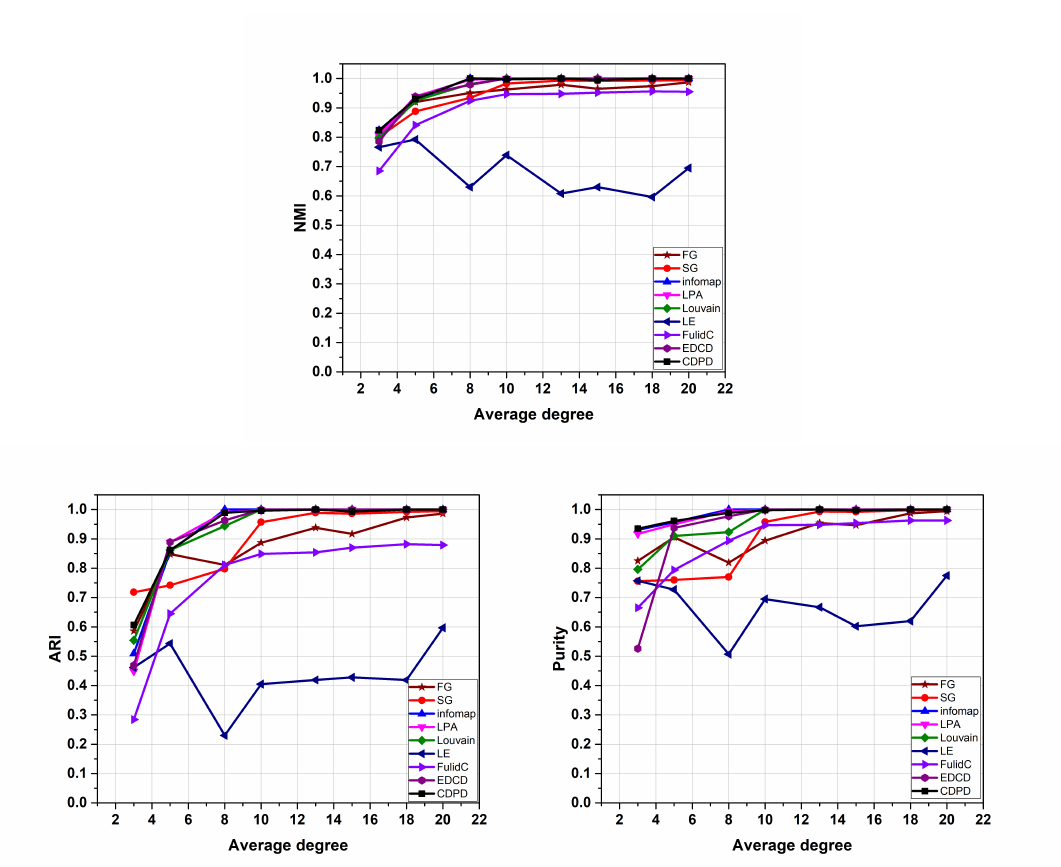
Figure 3. Performances of the above algorithms on the synthetic networks generated by LFR by varying the average degree k from 3 to